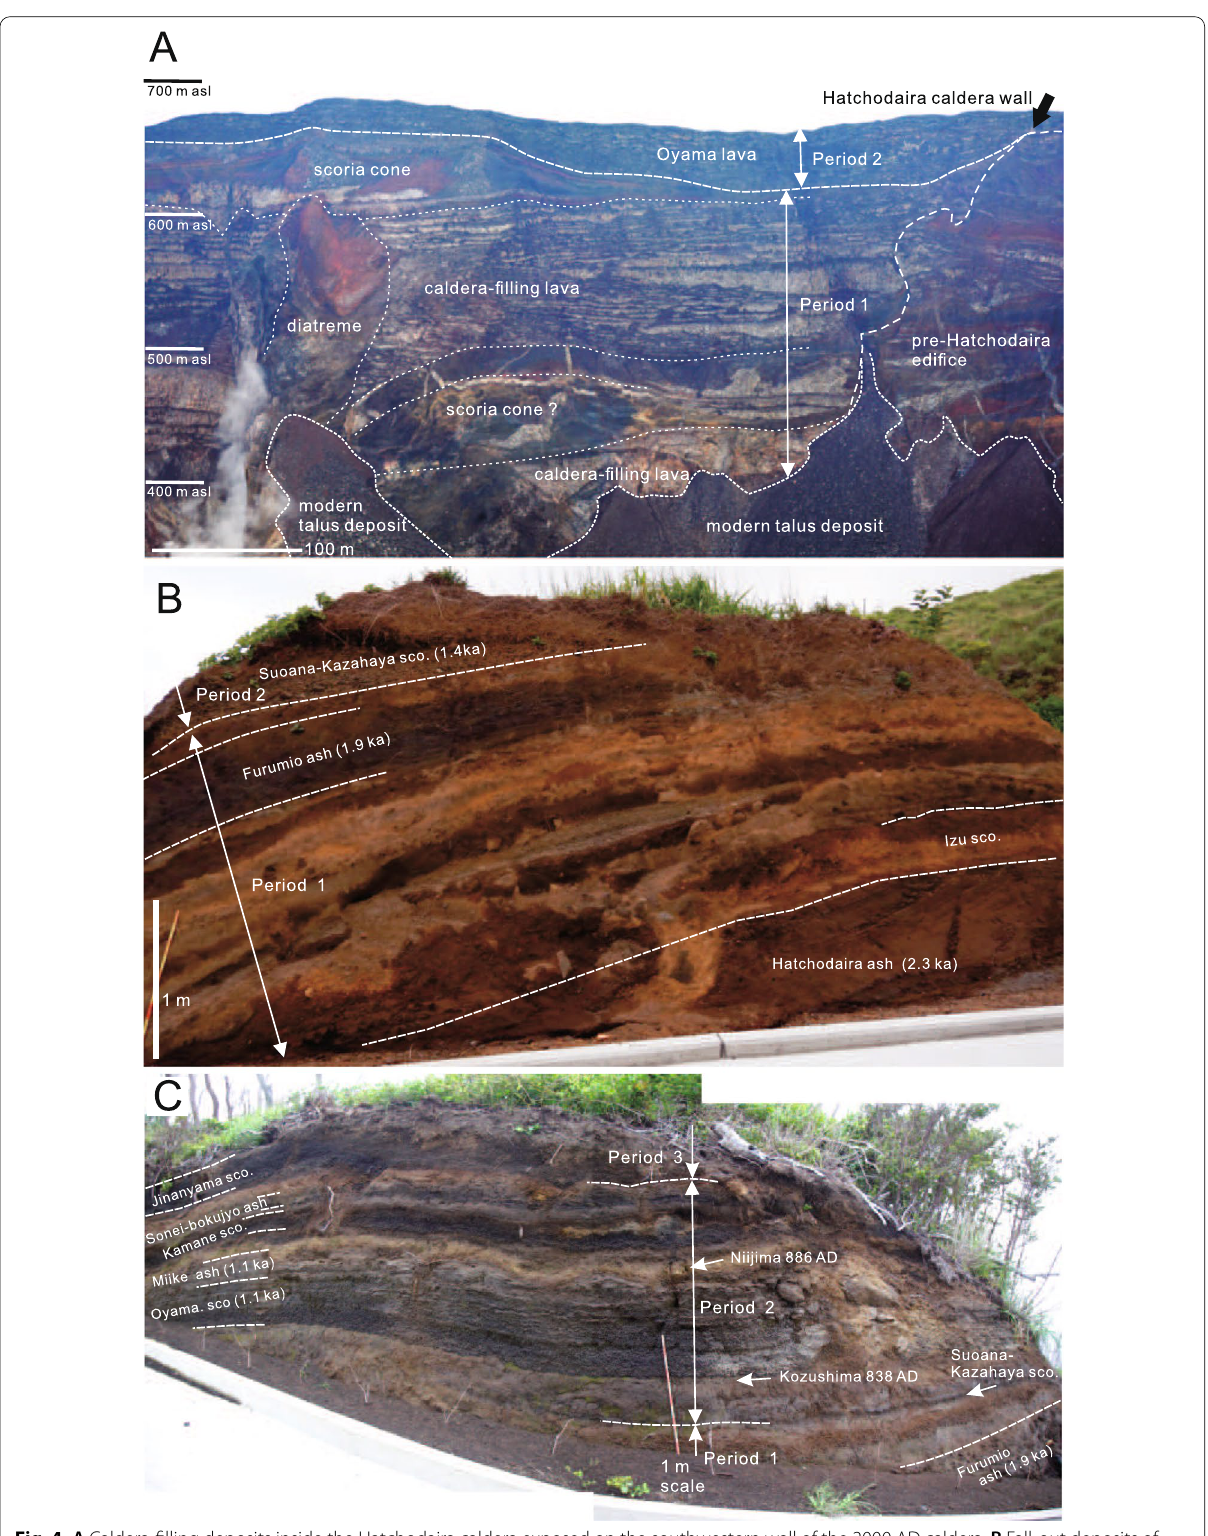
Fig. 4 A Caldera-filling deposits inside the Hatchodaira caldera exposed on the southwestern wall of the 2000 AD caldera. B Fall-out deposits of Period 1 overlying on the Hatchodaira ash. Location E2 of Fig. 5. C Fall-out deposit of Period 2 and 3 Location D of Fig.